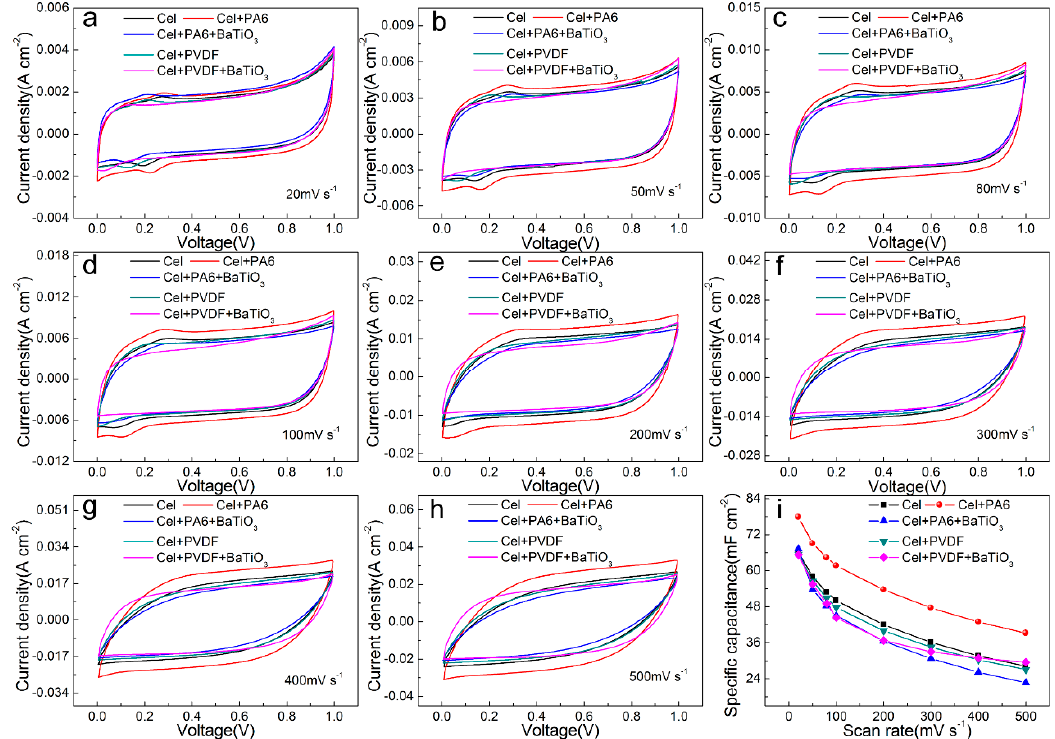
Figure 3. CV curve and specific capacitance curve of di ff erent types of friction layer: ( a ) 20 mV s − 1